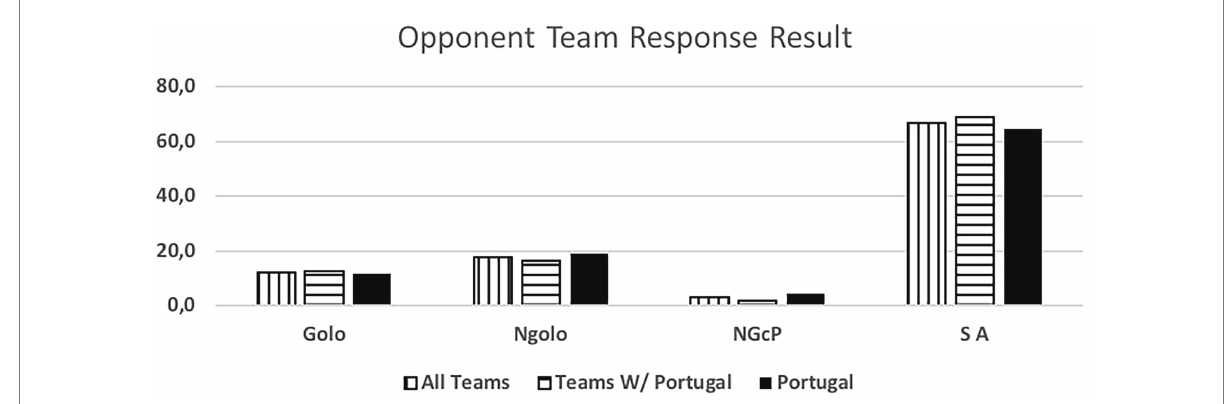
FIGURE 7 Opponent team response. Result golo, goal; Ngolo, no goal; NGcP, no goal with penalty (yellow card, 2 min, red card); SA, no response.